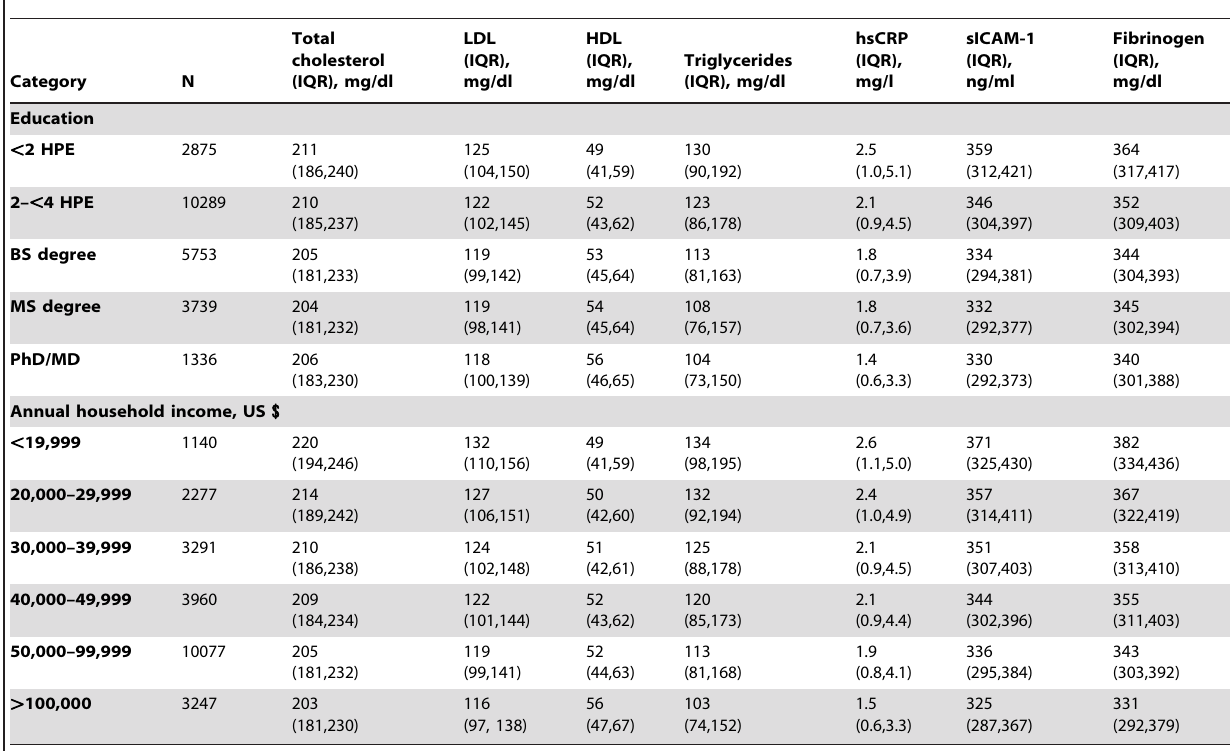
Table 2. Median level of Lipids, Inflammatory and Markers Based on Education and Income Categories*.